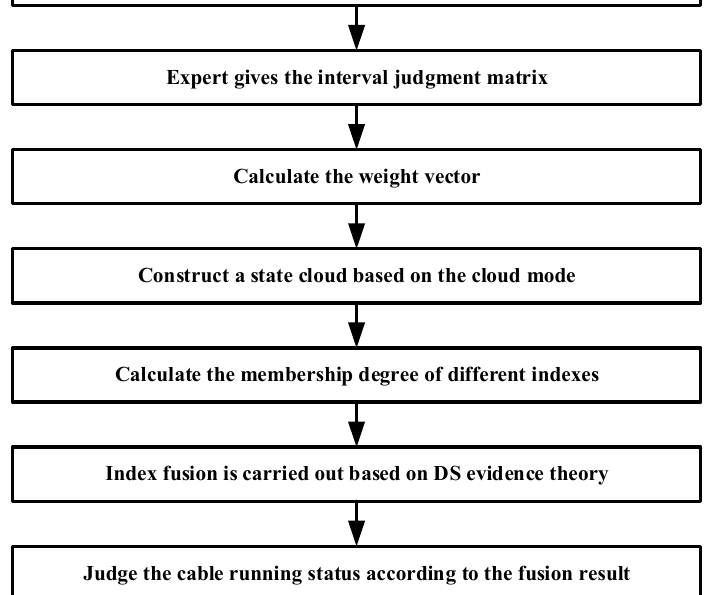
Figure 7. Evaluation algorithm flowchart.